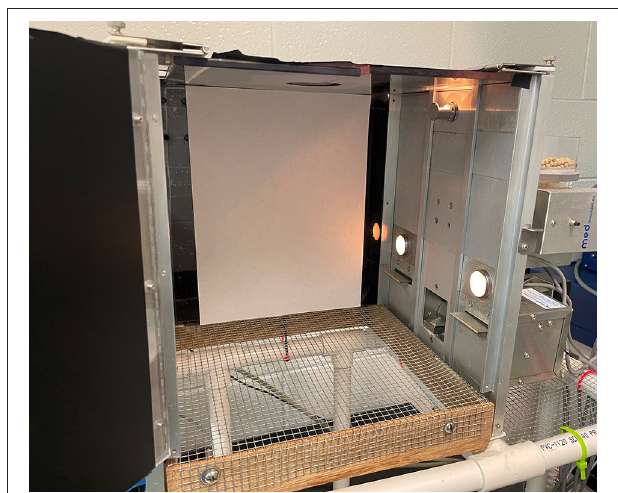
FIGURE 1 | The Med Associates Inc. operant chamber used for the approach-avoidance paradigm (AAP), designed with a wire mesh floor and levers located on the left and right sides of the food dispenser. Above each lever is a single stimulus light that serves as a cue to signal the active lever.